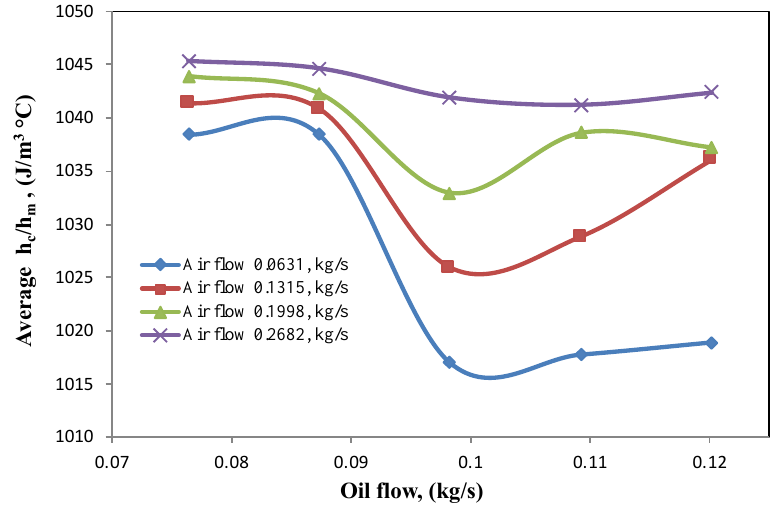
Figure 19. Average HD convective heat and mass transfer coefficient ratio at different air and oil flow rates.